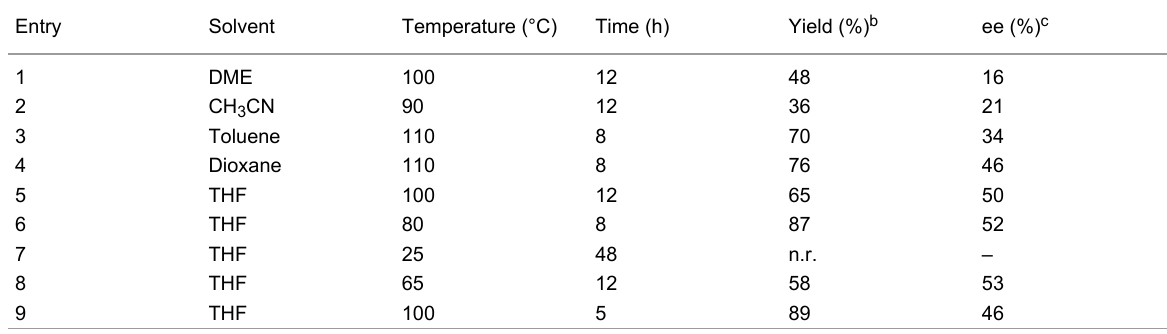
Table 1: Screening conditions for iridium-catalyzed asymmetric ring-opening of oxabenzonorbornadiene 1a with N -methylaniline. a